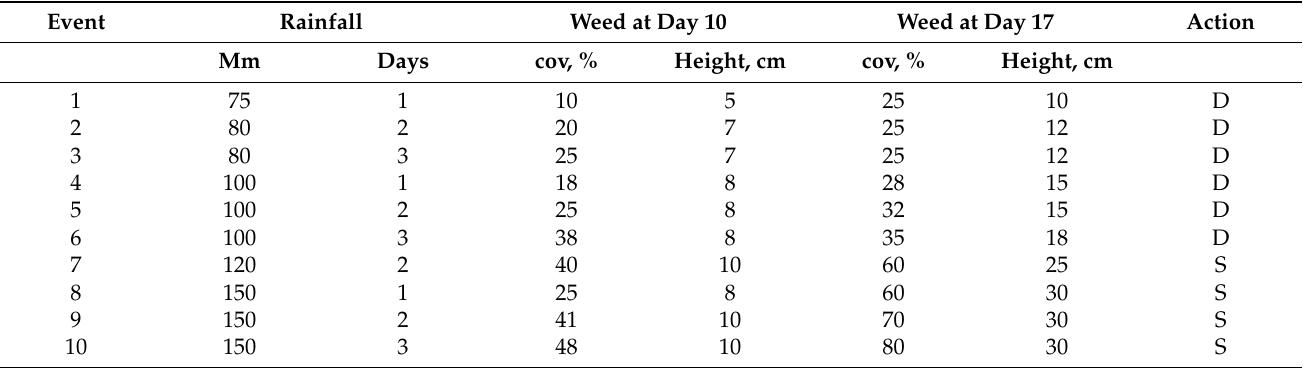
Table 1. Precipitation event with the number of rainy days and weed growth after 10 and 17 days within the micro-sprinkler